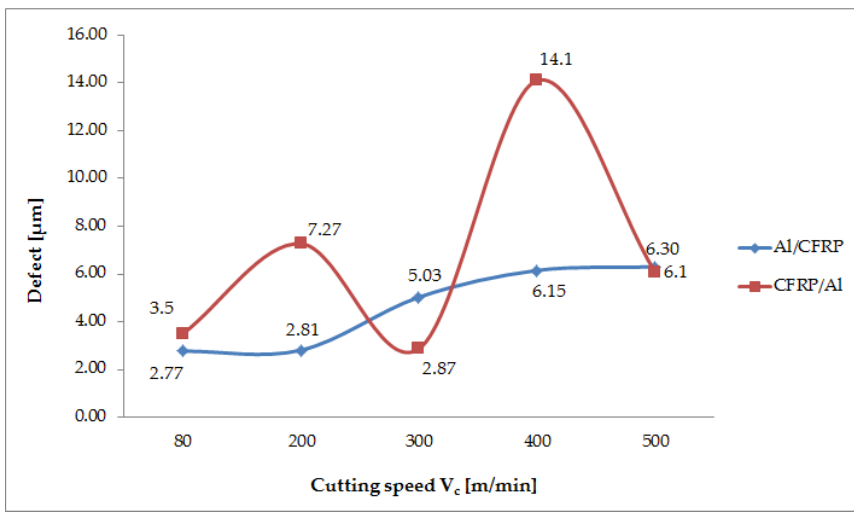
Figure 9. E ff ect of cutting speed change on value of defect. Figure 9. Effect of cutting speed change on value of defect.